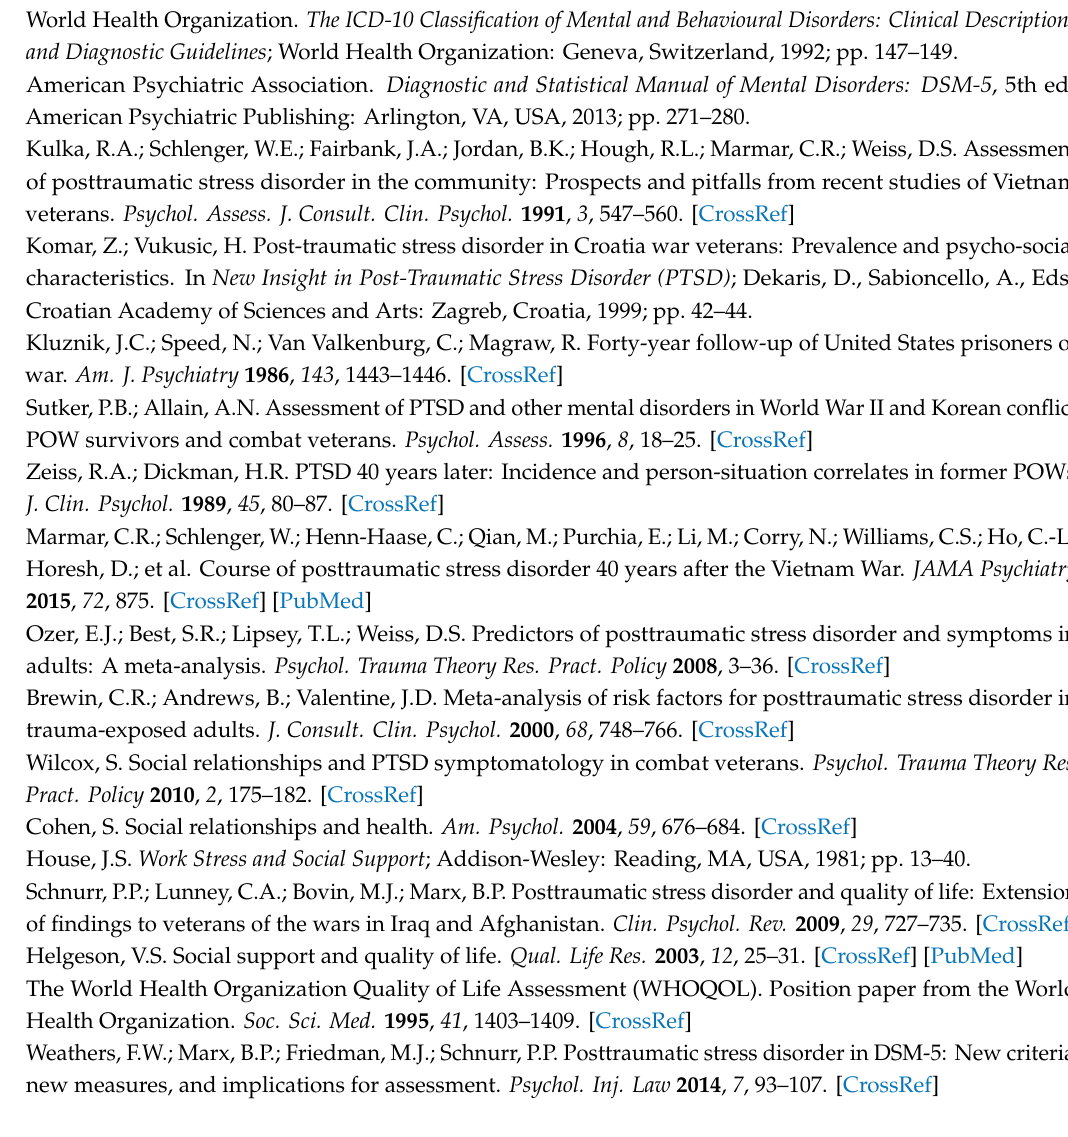
Figure S1: The perceived social support